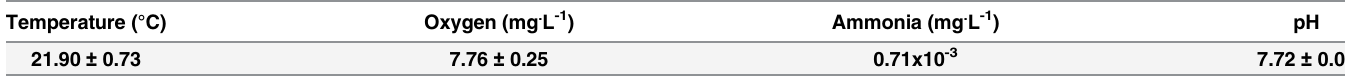
Table 2. Values (means ± S.D.) of temperature, rate of oxygen, ammonia and pH obtained from the aquaria during the experimental period.